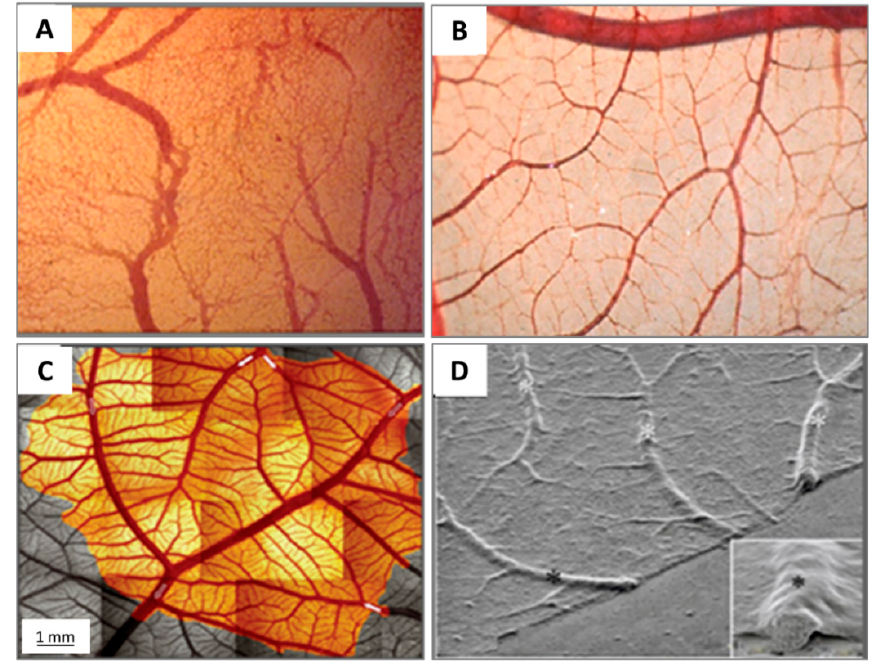
Figure 5. Images illustrating the maturation of the CAM vasculature. ( A ) Vascular remodelling, growth and anastomosis can be seen at ED 7; ( B ) hierarchic vascular structures and fully differentiated vessels are noted on ED 10; ( C ) vessel tree reconstruction and flow direction for major arterial and venous vessels (arrows); and ( D ) scanning electron microscope view of blood vessels on the CAM.